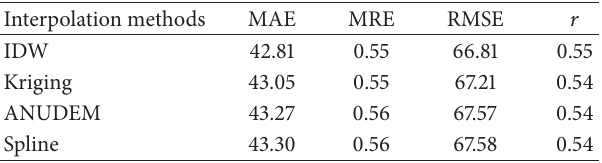
Table 1: Interpolation errors of monthly rainfall.